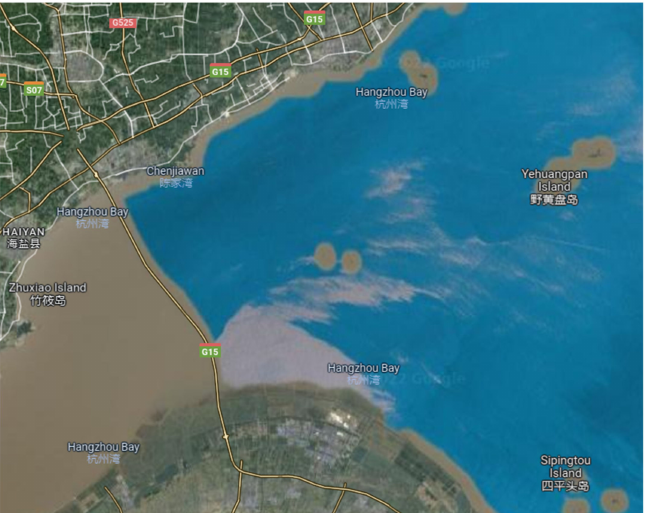
Figure 2. Location of the offshore windfarm.